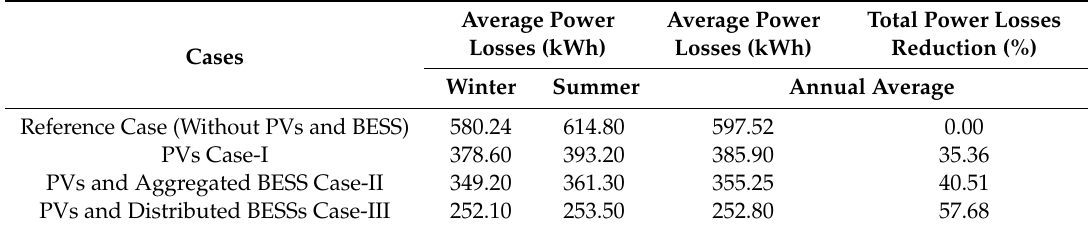
Table 1. Power losses reduction for the considered